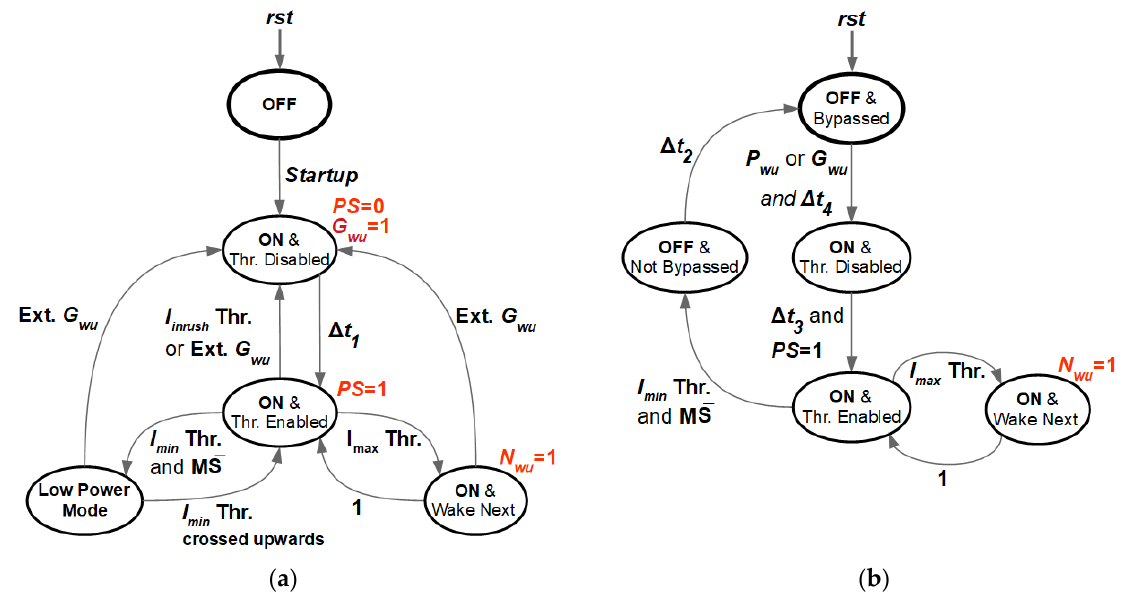
Figure 6. The state-machine description depending on the role of the local controller: ( a ) the LC is the Master; ( b ) the LC is a Slave (the abbreviations Thr., rst, and Ext. stand for Threshold, Reset, and External, respectively).